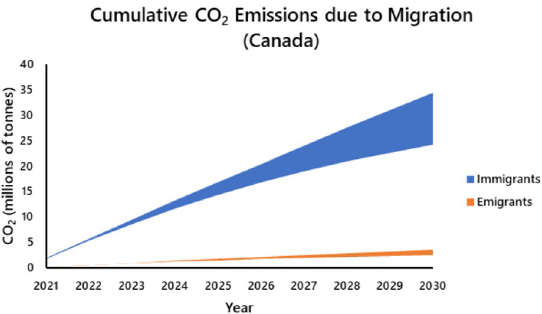
Fig 4. Projected annual cumulative CO 2 emissions associated with migration to and from Canada for the period 2021 to 2030. The upper limit of each curve assumes that Canada maintains 2005 emission levels, the lower limit assumes that Canada achieves an annual reduction of 3% (= 30% reduction by 2030). Shading represents the range of possibilities for partial achievement of reduction targets.